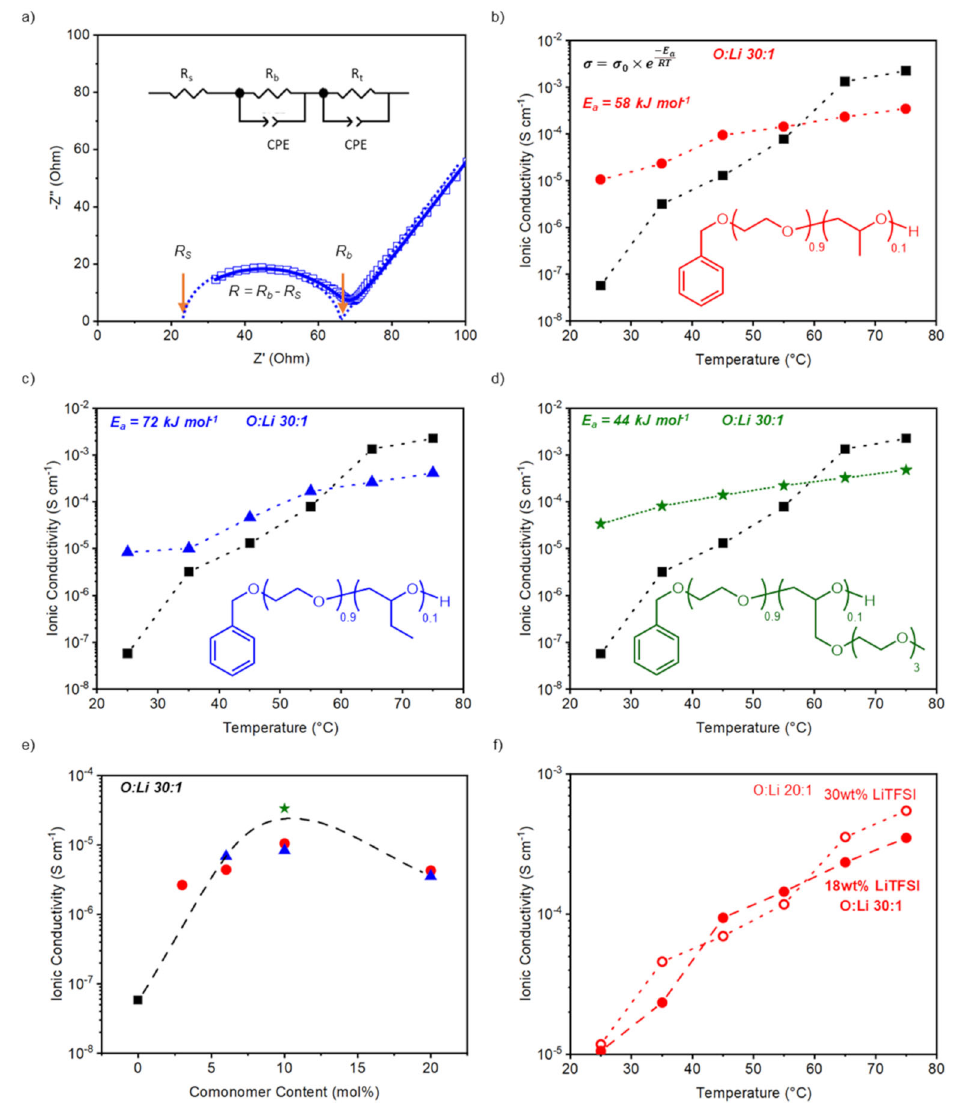
Fig. 3 Ionic conductivities of solid polymer electrolytes. a Graphical view of complex impedance graph obtained from electrochemical impedance spectroscopy (EIS) measurement, with experimental data (hollow square), fi tted data (solid blue line), and extension of fi tted curve (dashed blue line), calculated from the equivalent electronic circuit above the data. b Ionic conductivities vs temperature for sample PEO90PO10-18Li (in red) c sample PEO90BO10-18Li (in blue) d and sample PEO90TO10-18Li (in green), compared to sample PEO-18Li (in black). e Room temperature ionic conductivity vs comonomer content (polyethylene oxide (PEO) in black, copolymers of ethylene oxide with propylene oxide (PEOPO) in red, copolymers of ethylene oxide with 1,2-butylene oxide (PEOBO) in blue and copolymers of ethylene oxide with methyl ether triethylene glycol glycidyl ether (PEOTO) in green). f A comparison between the ionic conductivities of 18 wt% (full symbols) and 30 wt% (hollow symbols) lithium bis-(tri fl uoromethanesulfonyl)imide (LiTFSI) in sample PEO90PO10 vs